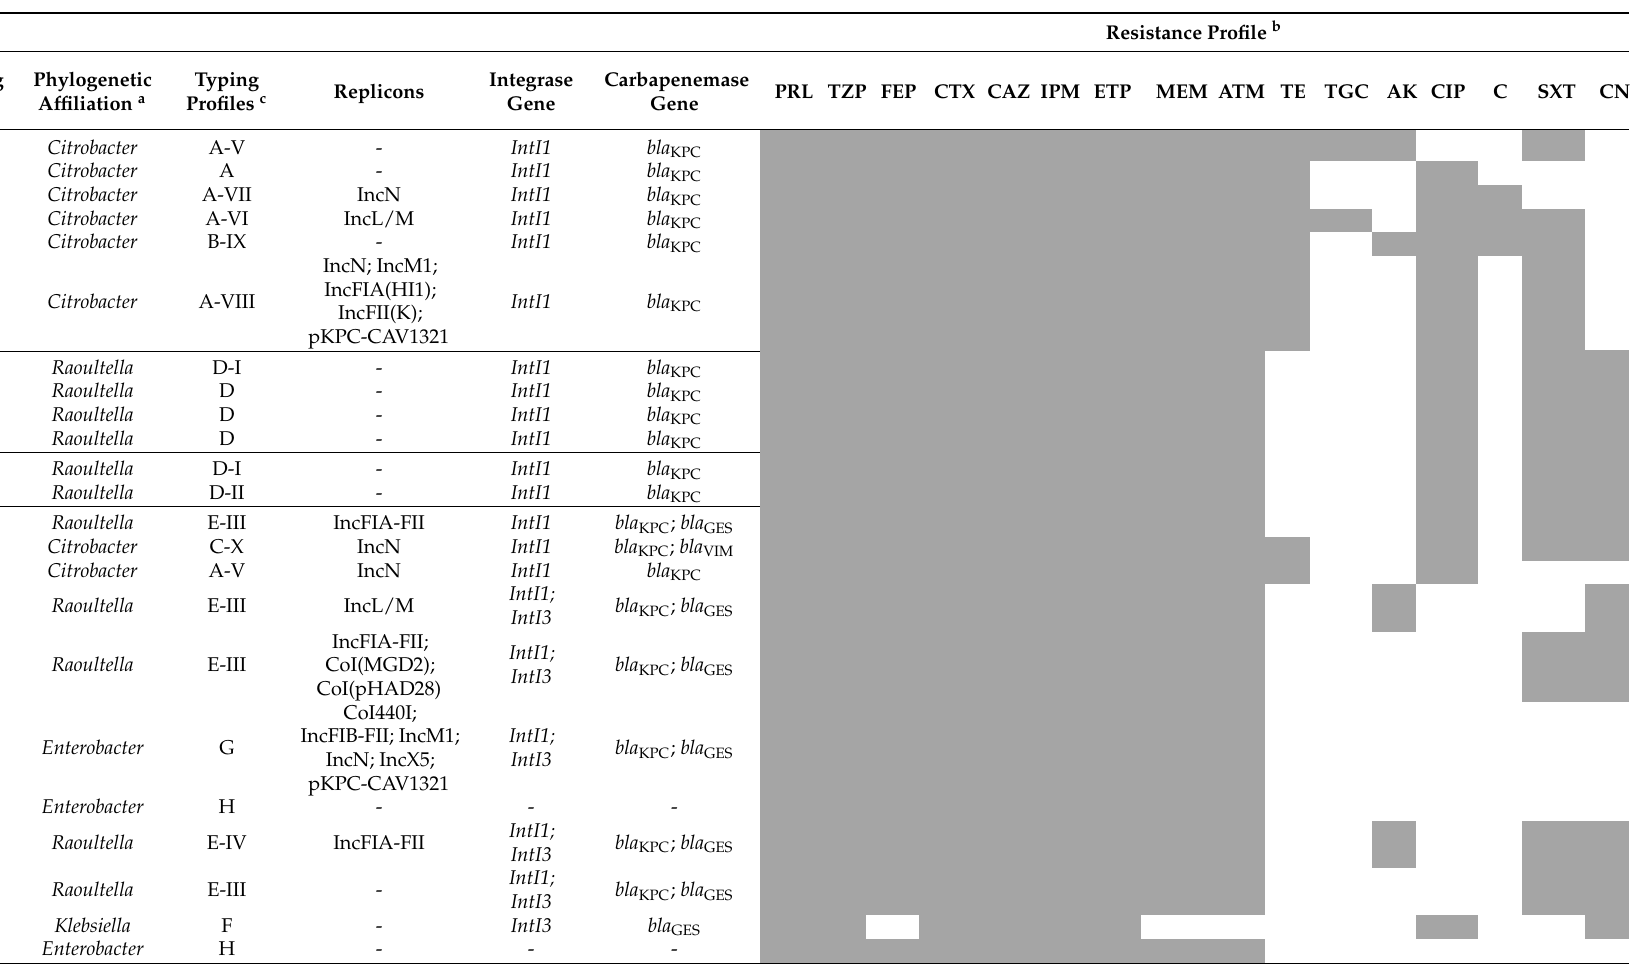
Table 1. Features of CRE obtained from the urban ponds (P) and estuarine canal (E).